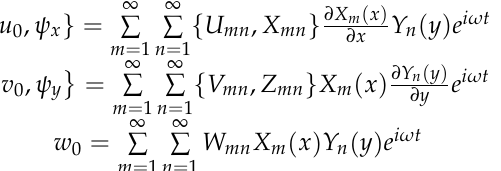
Table 2. The essential boundary conditions. BCs. Boundaries Parallel to the x -Axis Boundaries Parallel to the y -Axis Simply supported